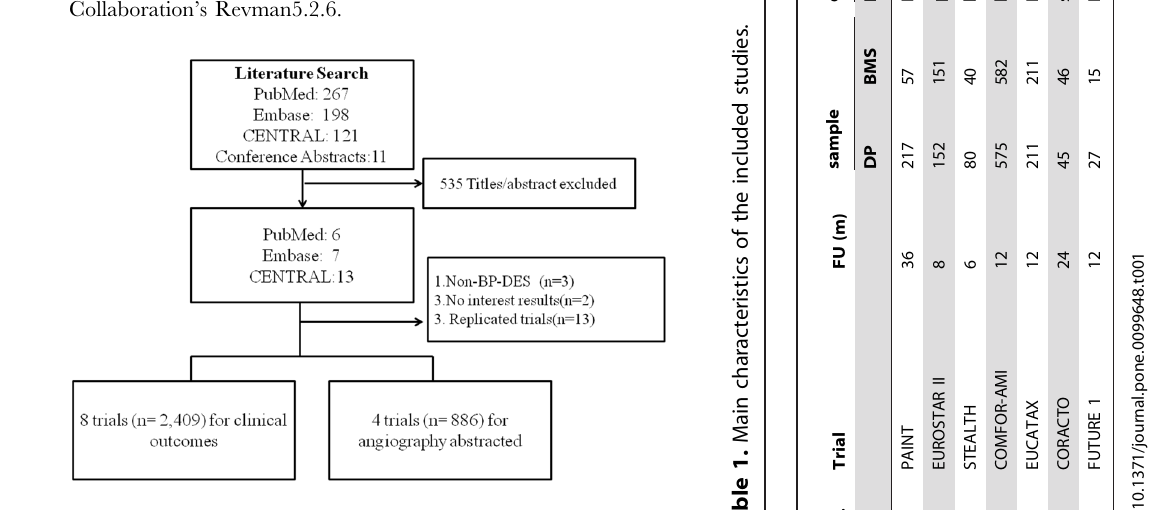
Figure 1. Flow diagram of the review process.